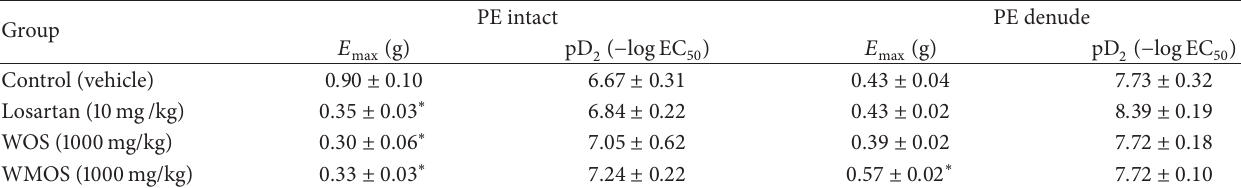
) for PE intact- and PE denude-induced contraction’s in aortic rings. 2